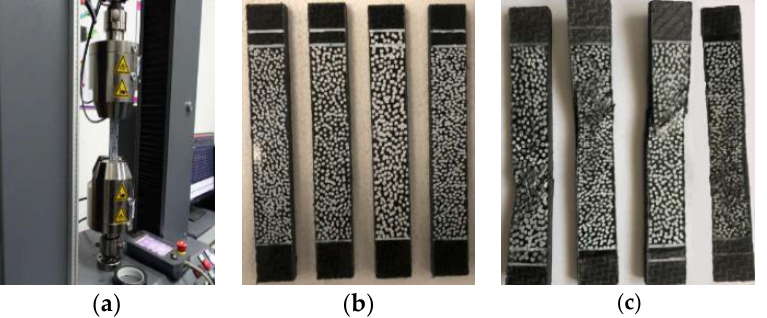
Figure 7. In-plane shear test at ±45° layer: ( a ) Test machine; ( b ) In-plane shear specimen; ( c ) Failure forms of specimens.